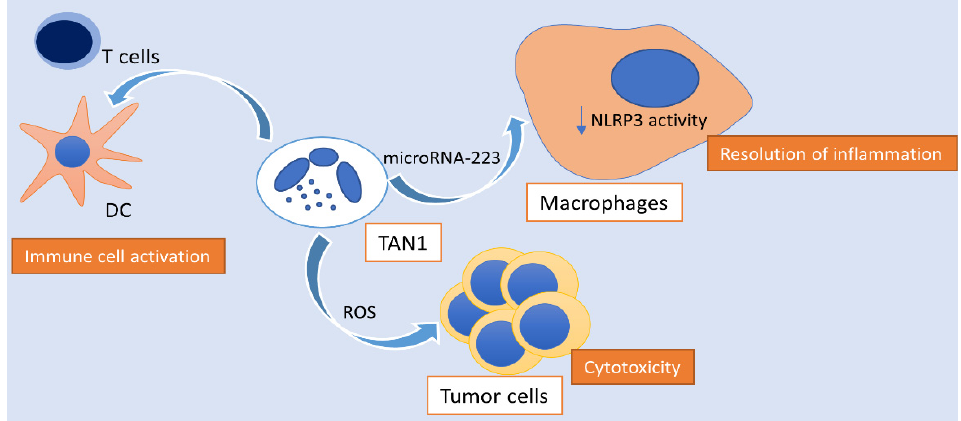
Figure 2. Activity of polarized N1 neutrophils in hepatocellular carcinoma. N1 TANs exhibit ROS-mediated cytotoxic activity towards tumor cells, activate the innate and adaptive immune response, as well as enhance the spontaneous resolution of tumor-associated inflammation via the transmission of microRNA-223 to macrophages, hindering NLRP3 activity. TAN: tumor-associated neutrophil; NLRP3: NLR family pyrin domain containing 3; ROS: reactive oxygen species; DC: dendritic cell.